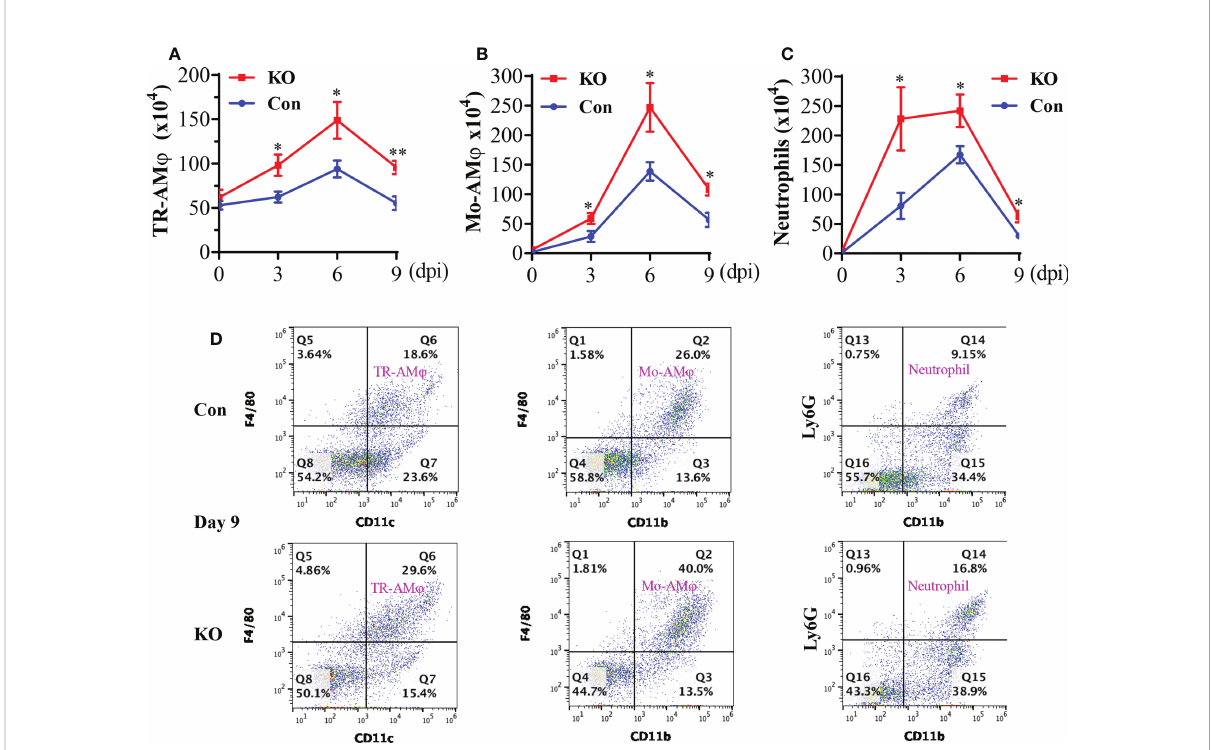
FIGURE 6 A general Runx3 KO in adult mice augments lung accumulation of innate immune cells in response to IAV Infection. Sex-and age-matched littermate control (Con) and Runx3 KO mice were infected with 1 LD 50 of H1N1 PR8 strain and BALFs were collected and subjected to fl ow cytometry analysis. TR-AM j (A) , Mo-AM j (B) , and neutrophils (C) were identi fi ed based on the selected surface markers and the cell absolute numbers were shown in bar graphs (A – C) . Results are presented as means ± SE. TR-AM j , n = 5-7; Mo-AM j , n = 5-6; neutrophils, n = 5-6. Unpaired Student ’ s t test was performed